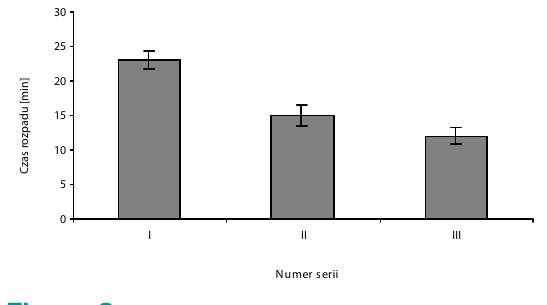
Figure 2. The rate of sodium ibuprofen release from tablets – a test with paddle method.